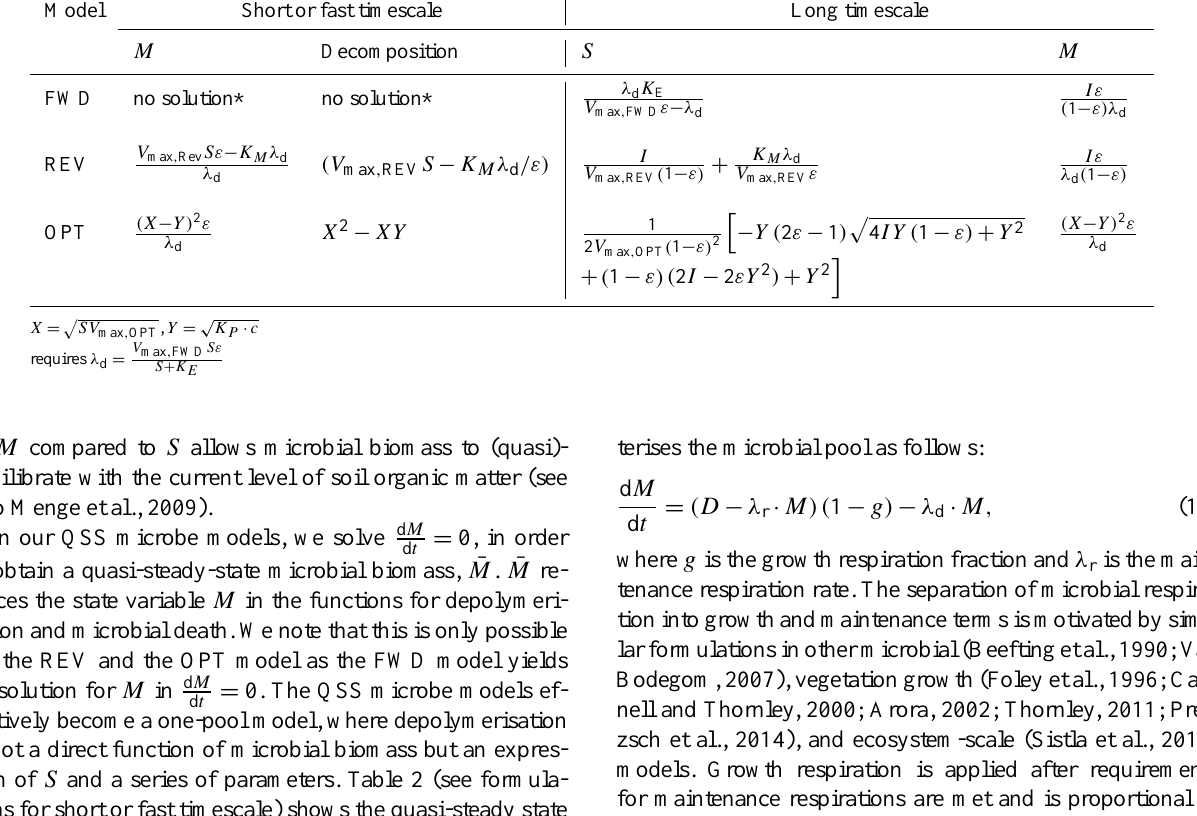
Table 2. Quasi-steady-state values for microbial biomass ( M ), and decomposition on the short or fast timescale (at any given S ) and “true” long-term equilibria for M and S across the models. Note that, for simplicity, we did not substitute S in the long-term microbial equilibrium for the OPT model. Model Short or fast timescale Long